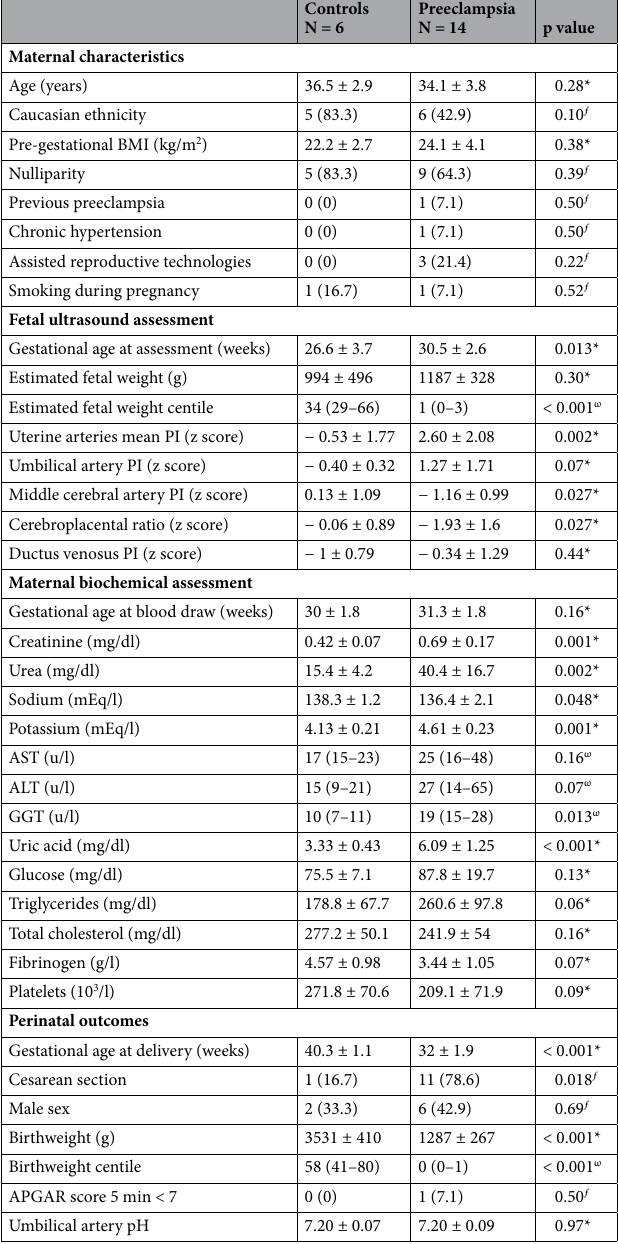
index, AST aspartate aminotransferase, ALT alanine aminotransferase, GGT gamma glutamyl transferase. P value was calculated by Student’s t (*), Mann Whitney U ( ω ) or Fisher exact ( ƒ ) tests as